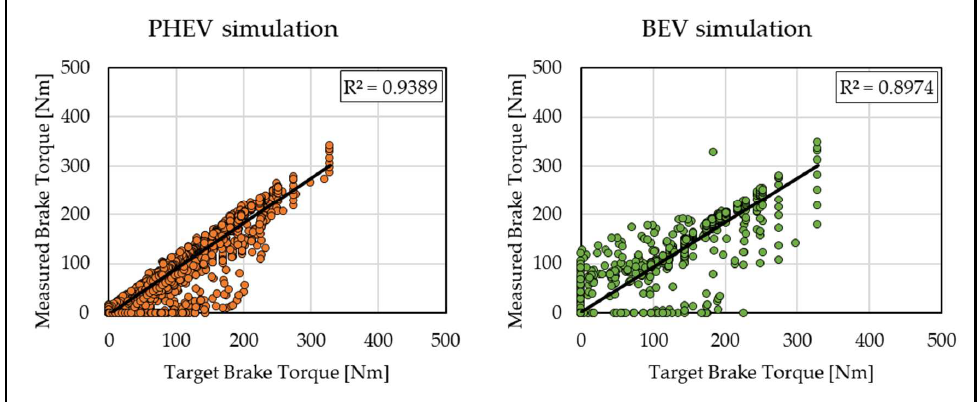
Figure 16. Linearity check of measured vs. target brake torque for brake blending simulation of PHEV and BEV recuperation.